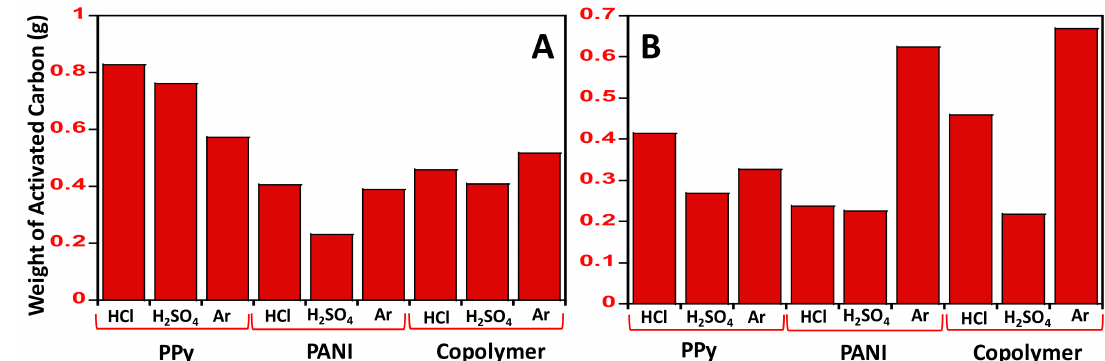
Figure 1. Graphical illustration of amount of activated carbon from pyrolysis of various polymers: ( A ) amount of N-GOs obtained when carbonization and activation were carried using polymer: KOH at a ratio of 1:2; ( B ) amount of N-GOs obtained when carbonization and activation were carried using polymer: KOH in the ratio of